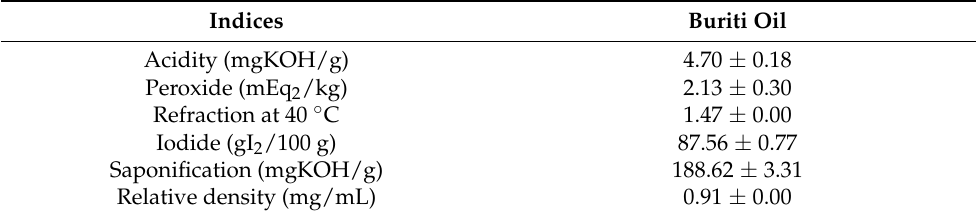
Table 3. Indices of quality and identity for the buriti